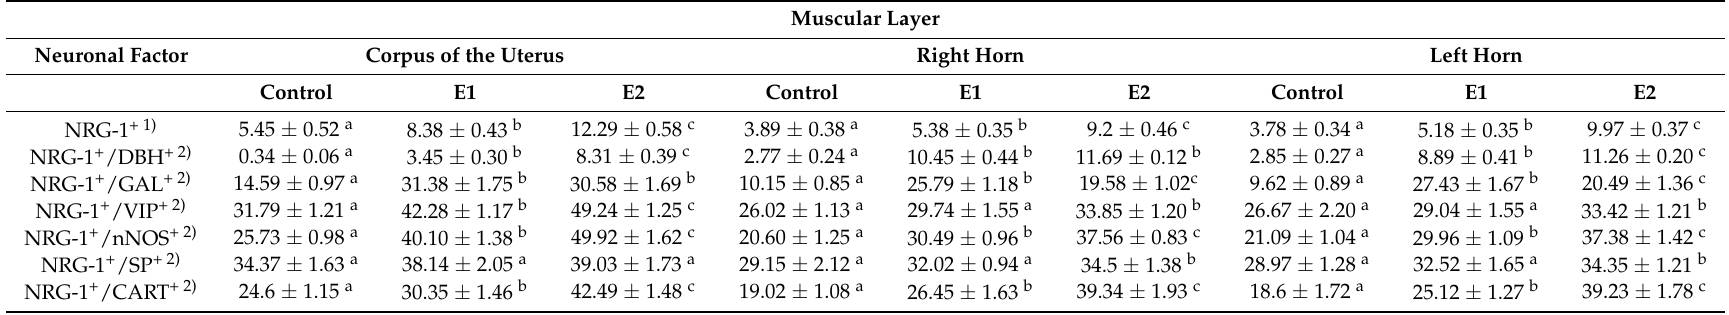
Table 1. Neuregulin-1-positive nerve fibers and their neurochemical characterization in the uterine muscular layer of the control animals (Control) and pigs treated with low (E1) and high (E2) doses of bisphenol A.